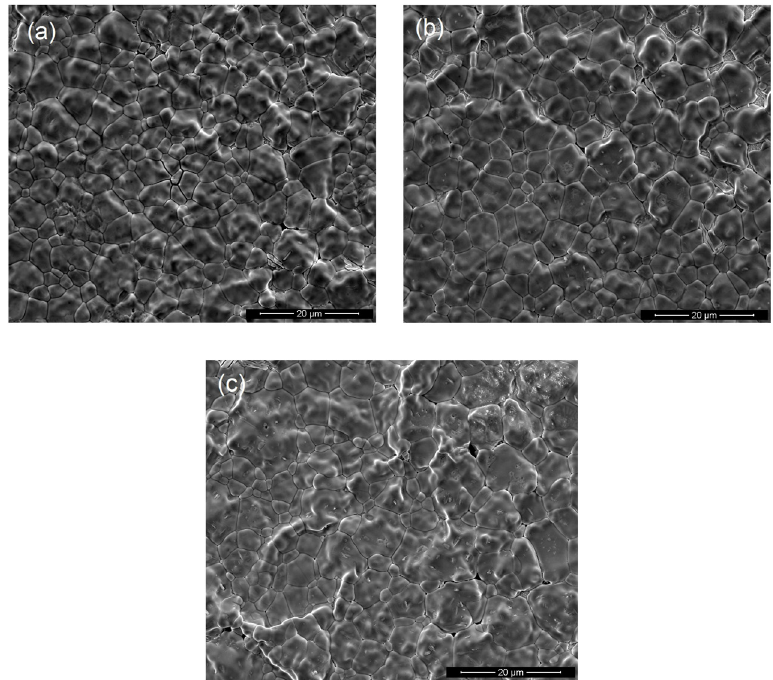
Figure 2. SEM images of the perovskite 24-h films fabricated via spray deposition at 120 °C and annealed for: a) 10 s; b) 20 s; c) 30 s.